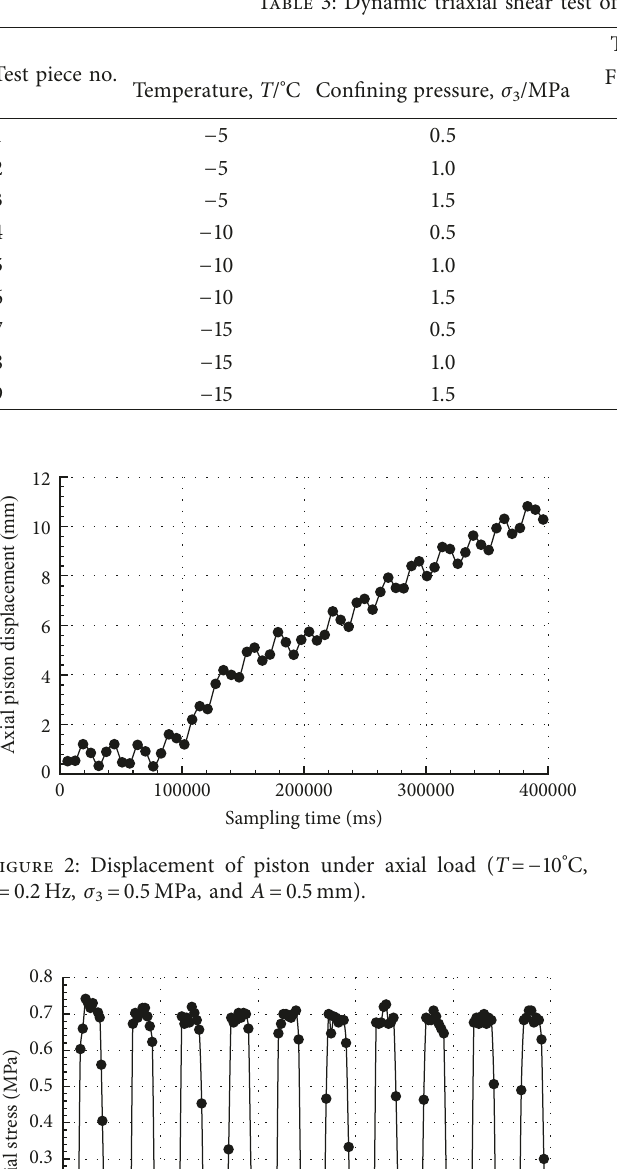
Figure 5: Stress-strain curve of frozen soil under the cyclic load 0.2Hz, σ 3 ( T 10 ° C, f (cid:31) (cid:31) −